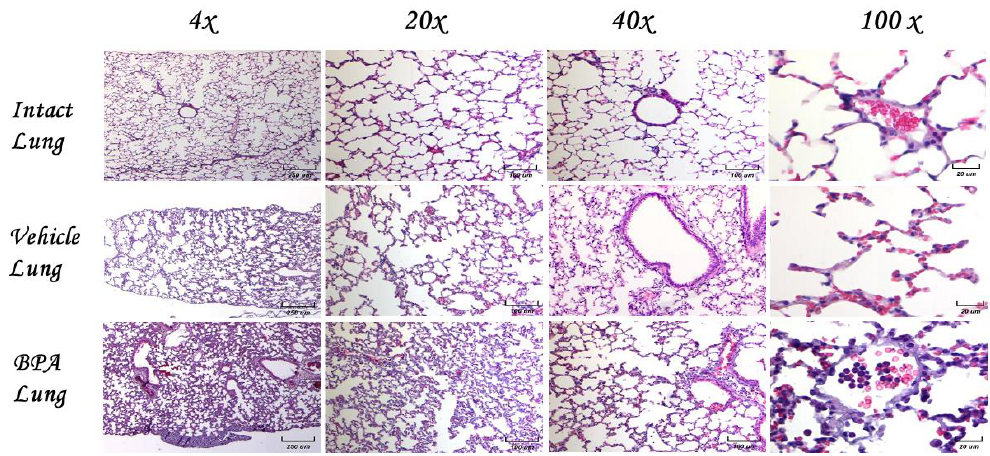
Figure 4. Histological examination of the lungs of female mice without tumors. Different magnifi- cation as indicated of lung tissues of different experimental groups. There is a normal histological appearance in intact or vehicle lungs, while BPA induces a slight infiltration of lymphocytes.